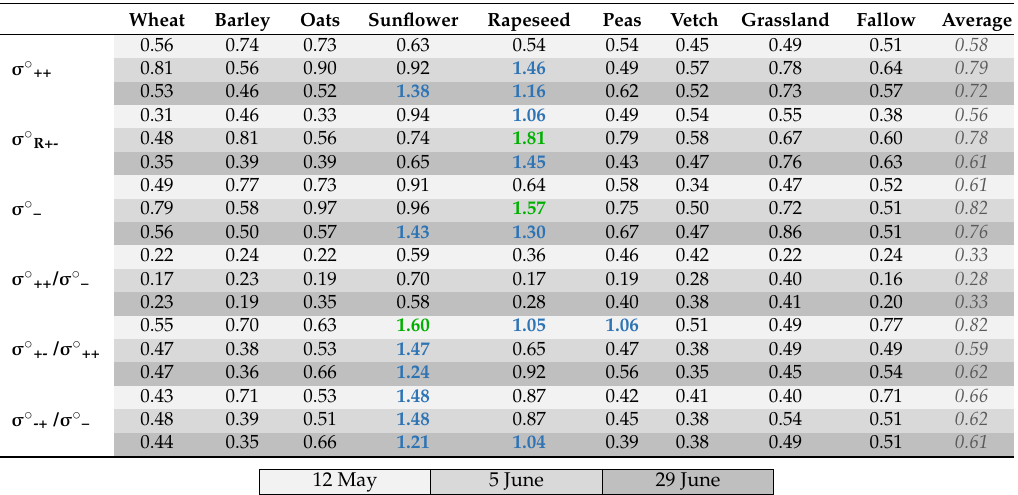
Table 3. Average JM distance for each studied crop and date as well as the average of all crop pairs, for σ ˝ ++ , σ ˝ + ´ , σ ˝ ´´ , and their ratios. Colors and shades as in Table 1.